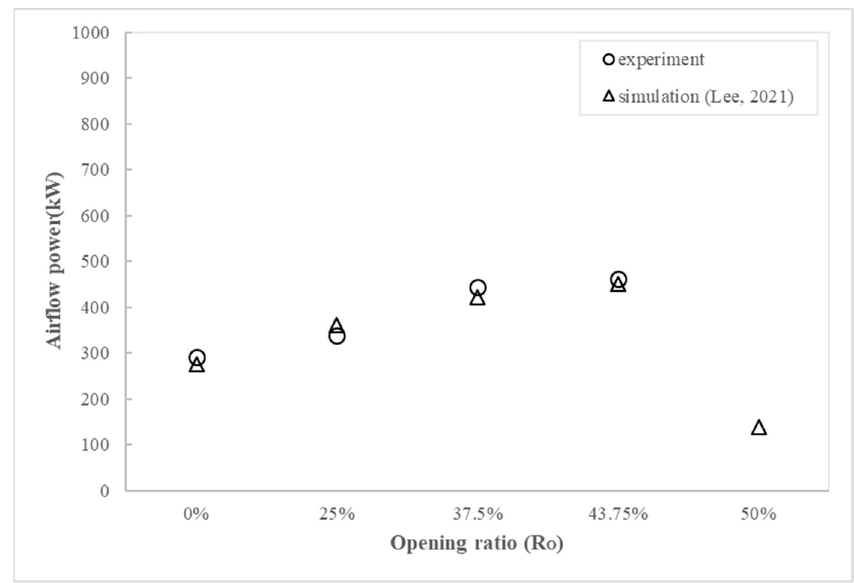
Figure 22. Comparison of the pneumatic power of air flow from the OWC with various opening ratios.